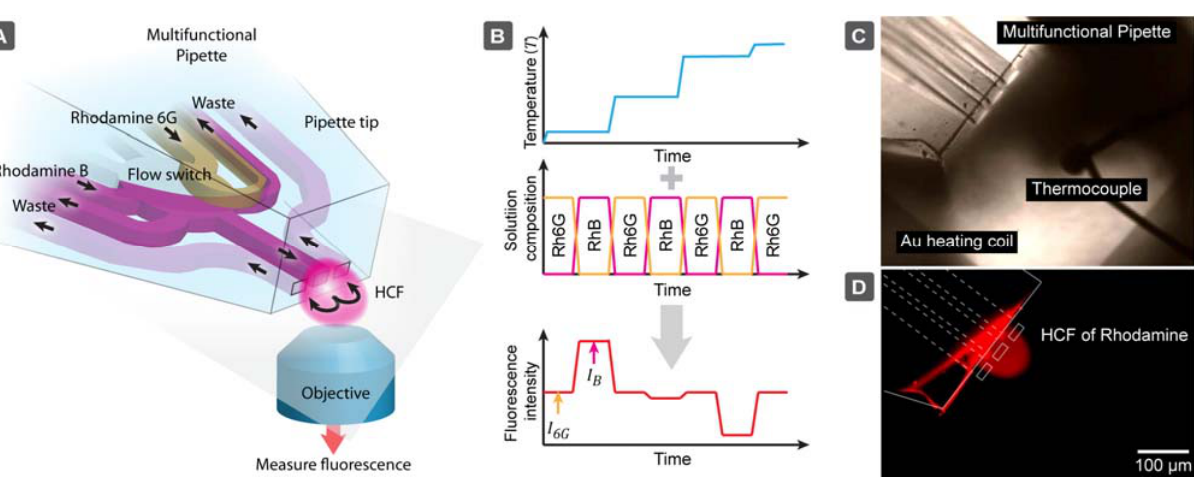
Figure 1. Concept of the microfluidic temperature probe with optical readout. ( A ) Schematic perspective view of the multifunctional pipette, which generates a hydrodynamically confined flow (HCF) in the environment where the temperature is probed. The content of this virtual flow cell can be quickly multiplexed between the strongly and weakly temperature responsive dyes. ( B ) The fluorescence signal of Rhodamine B (RhB) I increasing temperature, while the fluorescence intensity of Rhodamine 6G (Rh6G) I slightly influenced by temperature change. Outlined within is the concept of coupling the alternation of a change in temperature. ( C ) Micrograph of the multifunctional pipette in the calibration setup on top of a surface printed thin film heater (dark areas in left and right bottom corners) and a type E microthermocouple as a reference sensor. ( D ) Fluorescence image of the rhodamine HCF generated at the tip of the pipette (top down view). The diagonal line observed, is an artifact due to the pipette contacting the surface, which does not interfere with the flow or